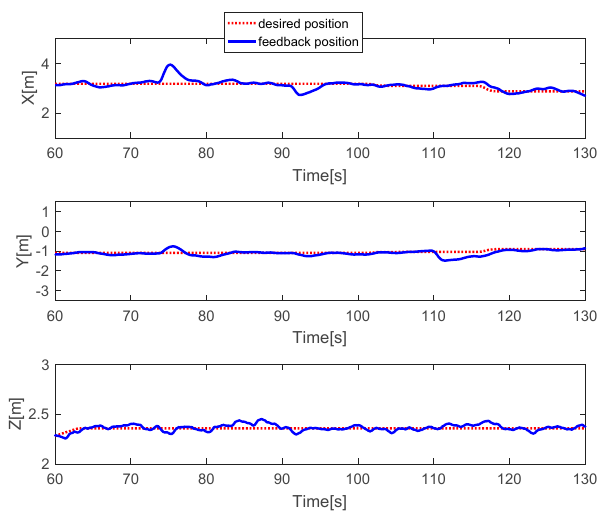
Figure 11. Horizontal and vertical movement.